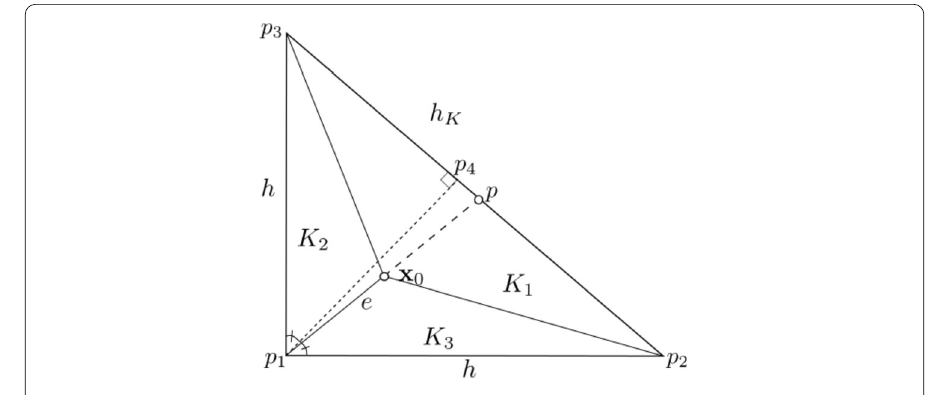
Figure 5 A right isosceles triangle K 1, π